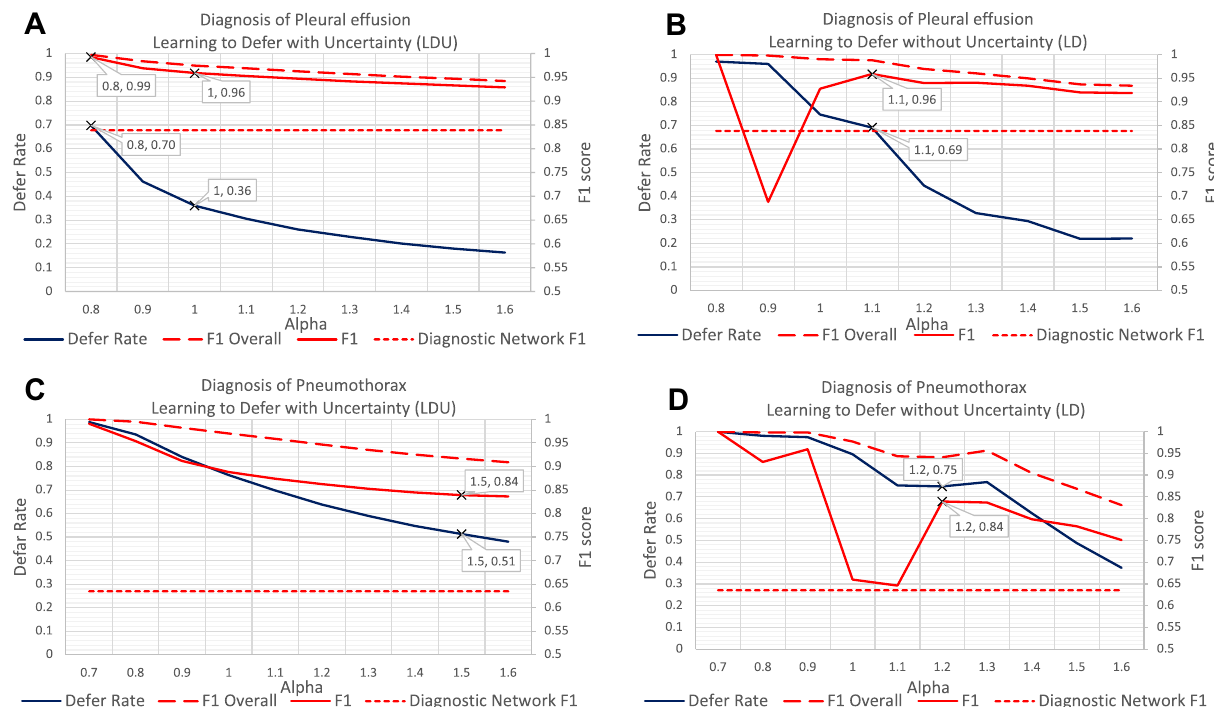
Figure 4. Performance comparison for the diagnostic tasks using MIMIC-CXR x-ray images: diagnosis of pleural effusion using (A) learning to defer with uncertainty (LDU) and (B) learning to defer without uncertainty information (LD), diagnosis of pneumothorax using (C) learning to defer with uncertainty (LDU) and (D) learning to defer without uncertainty information (LD). Each panel shows the F1 scores (red line) for patients who are not deferred to human experts, ‘F1 Overall’ scores (red dashed line) and the corresponding defer rates (blue line) for different values of the weight of the defer loss α . The diagnostic network F1 score (without the defer option) is 0.84 for pleural effusion, and 0.63 for pneumothorax (red dotted line).